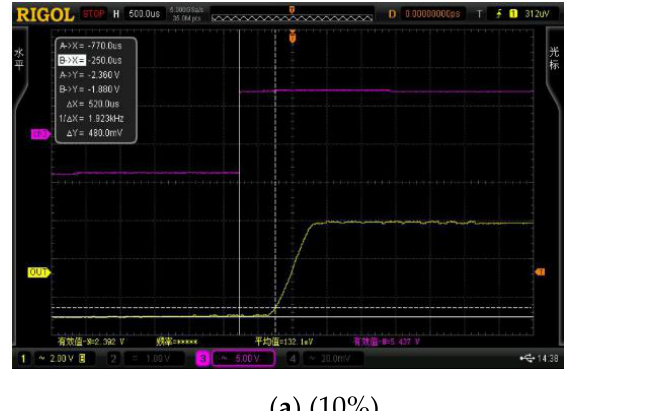
Figure 20. The diagram of testing device.